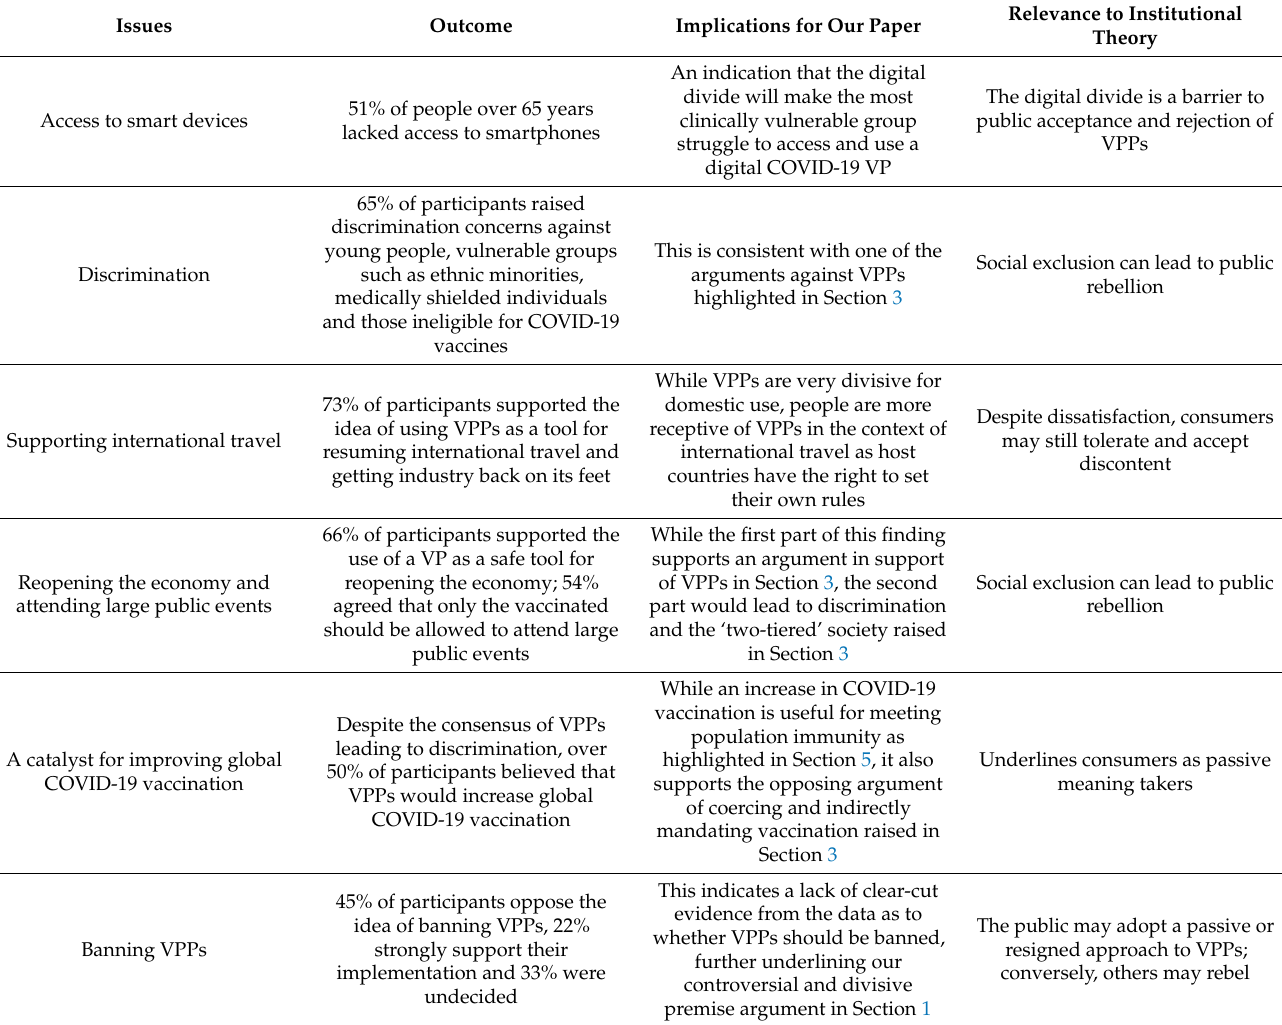
Table 2. Highlights from Ipsos MORI’s survey on COVID-19 vaccine passport